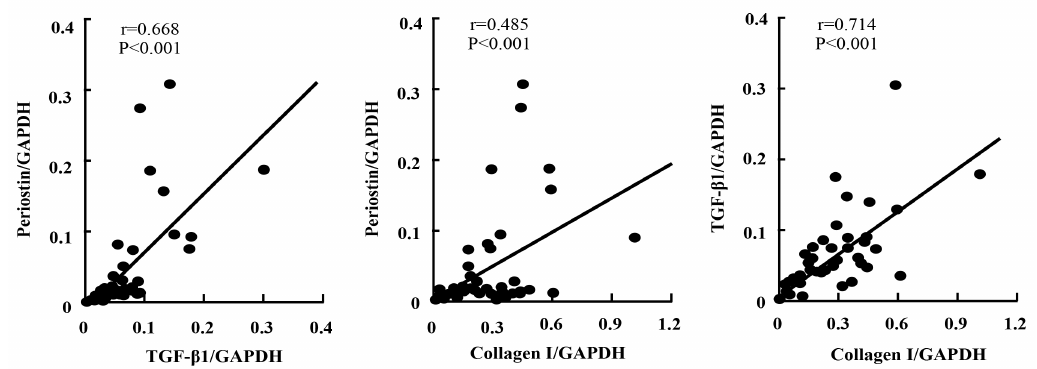
Figure 5. Linear regression analyses of the correlations among the expression levels of periostin, TGF-β1, and collagen I after PTFE graft implantation, independent of time point and region.